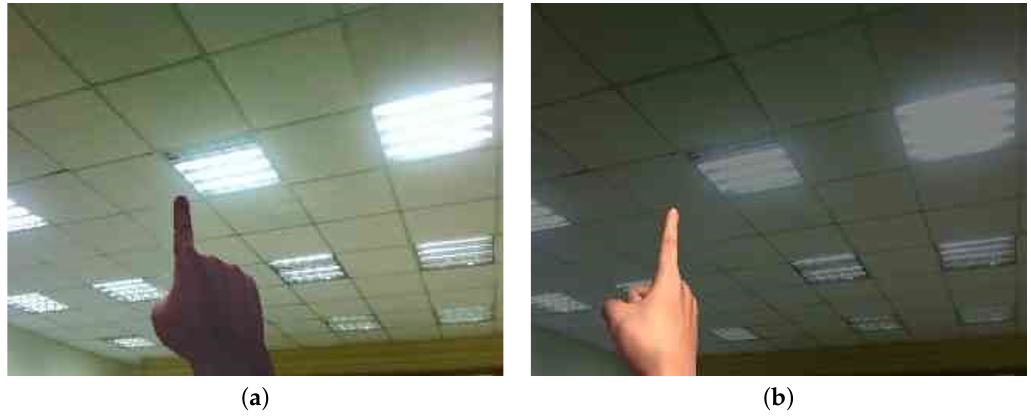
Figure 8. Challenging cases of fingertip detection in: ( a ) a very light environment; and ( b ) a very dark environment. Our dataset contains 311,972 images for training and 188,732 images for validation with a resolution of 640 × 480 pixels. All images have fingertip annotations with high ImageNet